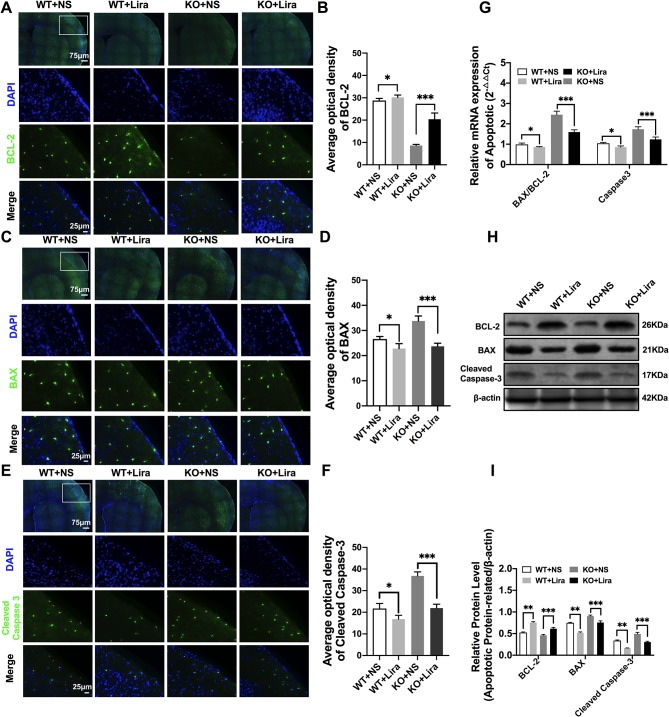
Liraglutide blocked apoptosis in Scn1a KO-induced epileptic mice. (A, C, E) Representative images of immunofluorescent staining with BCL-2/BAX/Cleaved Caspase-3 (green), and DAPI (blue) in the ipsilateral side of the cortex of the WT and Scn1a KO mice. Scale bar: 75 μm for the full-scale images and 25 μm for the magnified images. (B, D, F) Summary graph of the average optical density of BCL-2, BAX, and Cleaved Caspase-3 fluorescent staining measured in images (A, C, E) in the cortex of mice (N = 24 mice per group; One-way ANOVA, Student’s t-test). (G) RT-qPCR analysis of the BAX/BCL-2 and Caspase-3 expression from brains of wild-type (WT) and Scn1a KO heterozygote (KO) mice (N = 24 mice per group; One-way ANOVA, Student’s t-test). (H) Representative western blotting showing BAX/BCL-2 and Cleaved Caspase-3 protein expression in brains of WT and Scn1a KO mice. (I) Summary graph of western blotting analysis demonstrating a significant reduction in the apoptosis-related protein in brains of Scn1a KO as compared to WT mice after liraglutide administration (N = 24 mice per group; Student’s t-test, P < 0.001). The relative expression of apoptosis-related protein was normalized to reference controls Gapdh and β-actin in RT-qPCR and Western blotting, respectively. Data were presented as mean ± SD; *, **, *** represent P < 0.05, P < 0.01 and P < 0.001, respectively. All experiments were performed in triplicate. WT, Wild-type; KO, Scn1a Knockout heterozygotes (F1); NS, Normal saline; Lira, Liraglutide.